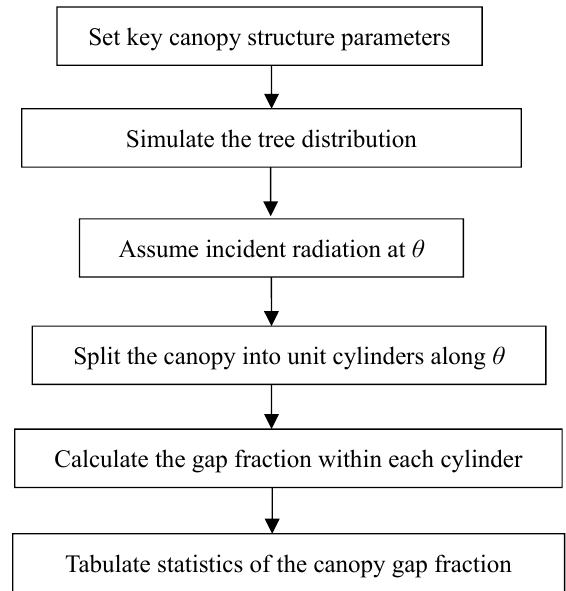
Figure 3. Calculation processes for forest average gap fraction.